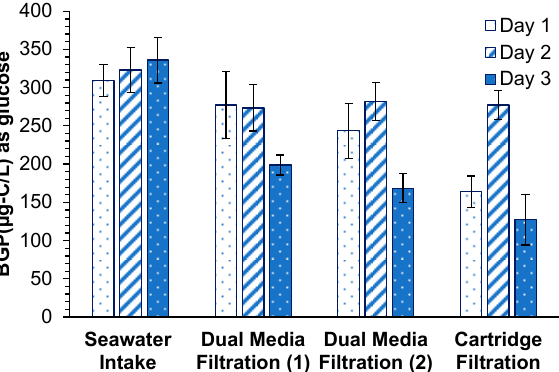
Figure 5. Bacterial growth potential during the RO pretreatment processes of a full-scale SWRO desalination plant.